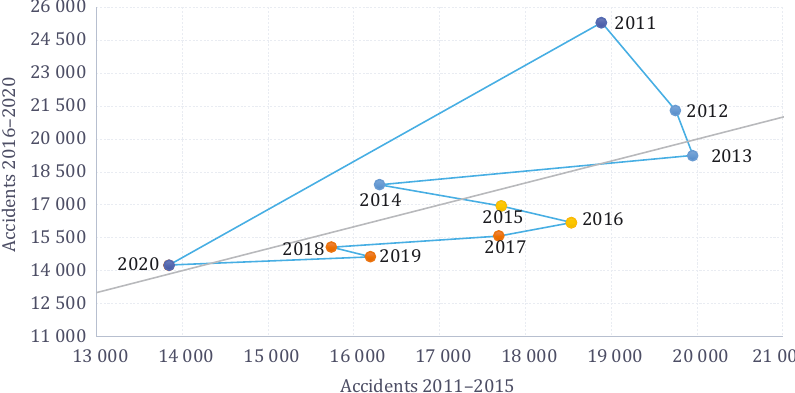
Figure 15. IPTA diagram of the power trend